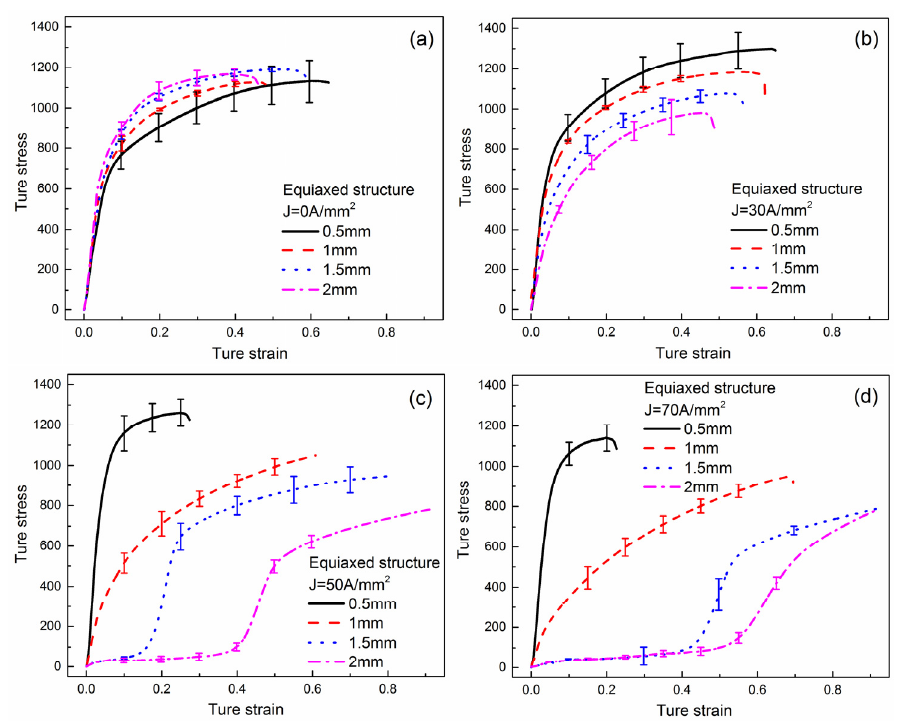
Figure 6. True stress-true strain curves of equiaxed microstructure specimen with different specimen sizes: ( a ) 0.5 mm, ( b ) 1 mm, ( c ) 1.5 mm, ( d ) 2 mm.